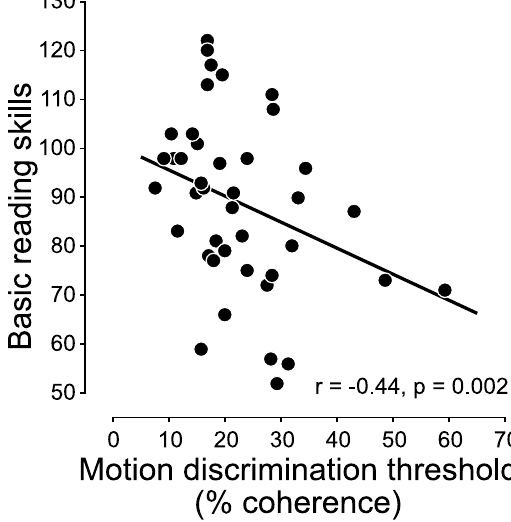
Figure 1. Correlation between motion sensitivity and reading skills. Basic reading skills (Woodcock-Johnson IV) are plotted as a function of motion discrimination threshold (percent coherence) for each